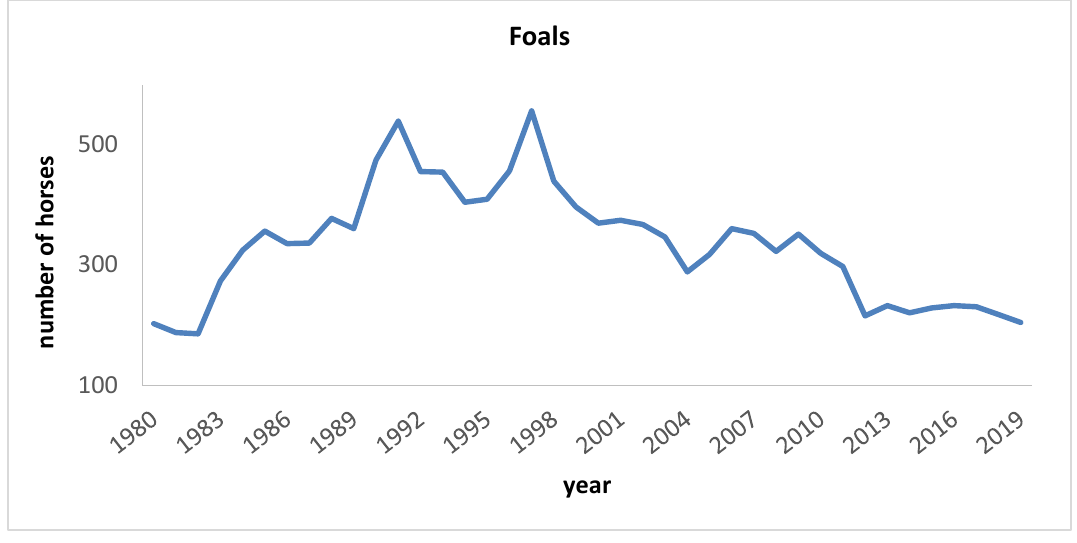
19.81% ± 2.06 in males and 18.92% ± 2.71 in females (Figure 2).